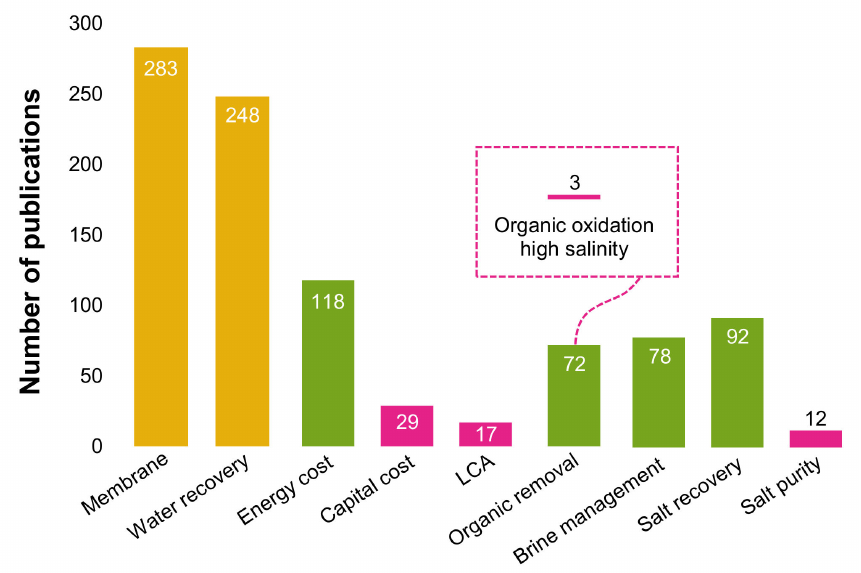
Figure 2. Literature survey of articles (Web of Science Core Collection) in topics related to “Zero liquid discharge” from 2000 to 2021 (search date: 13 September